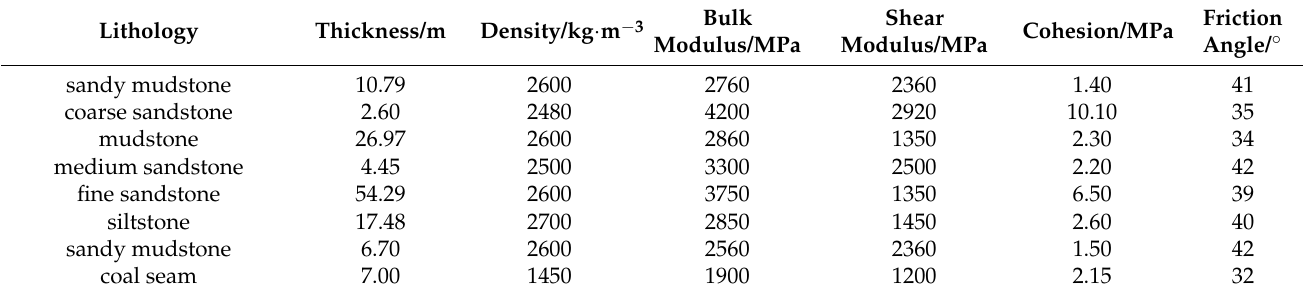
Table 1. Stratification and mechanical parameters of rock and coal.